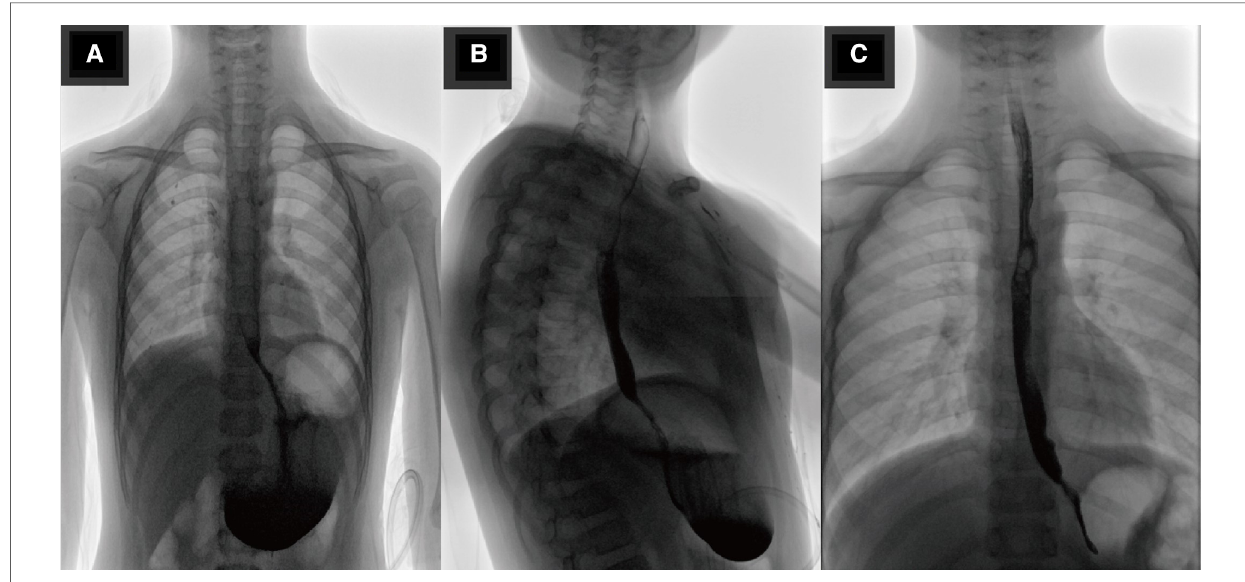
FIGURE 5 ( A,B ) Show the radiological investigation of the child: positive and lateral upper gastrointestinal radiographs reviewed 10 days after surgery, showing good recovery. ( C ) Shows the radiological investigation of the child: re-examination of the upper gastrointestinal tract contrast study 2 months after surgery, showing good